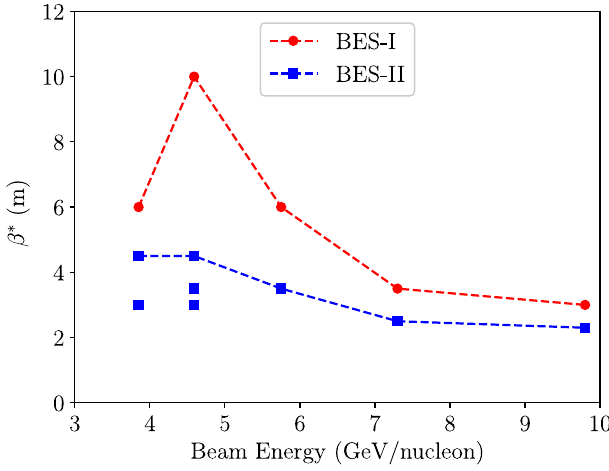
FIG. 17. Initial β (cid:2) values were smaller during BES-II than during BES-I, at all beam energies. The β (cid:2) values were reduced even more during stores with electron cooling: once at 3 . 85 GeV = nucleon and twice at 4 . 59 GeV =